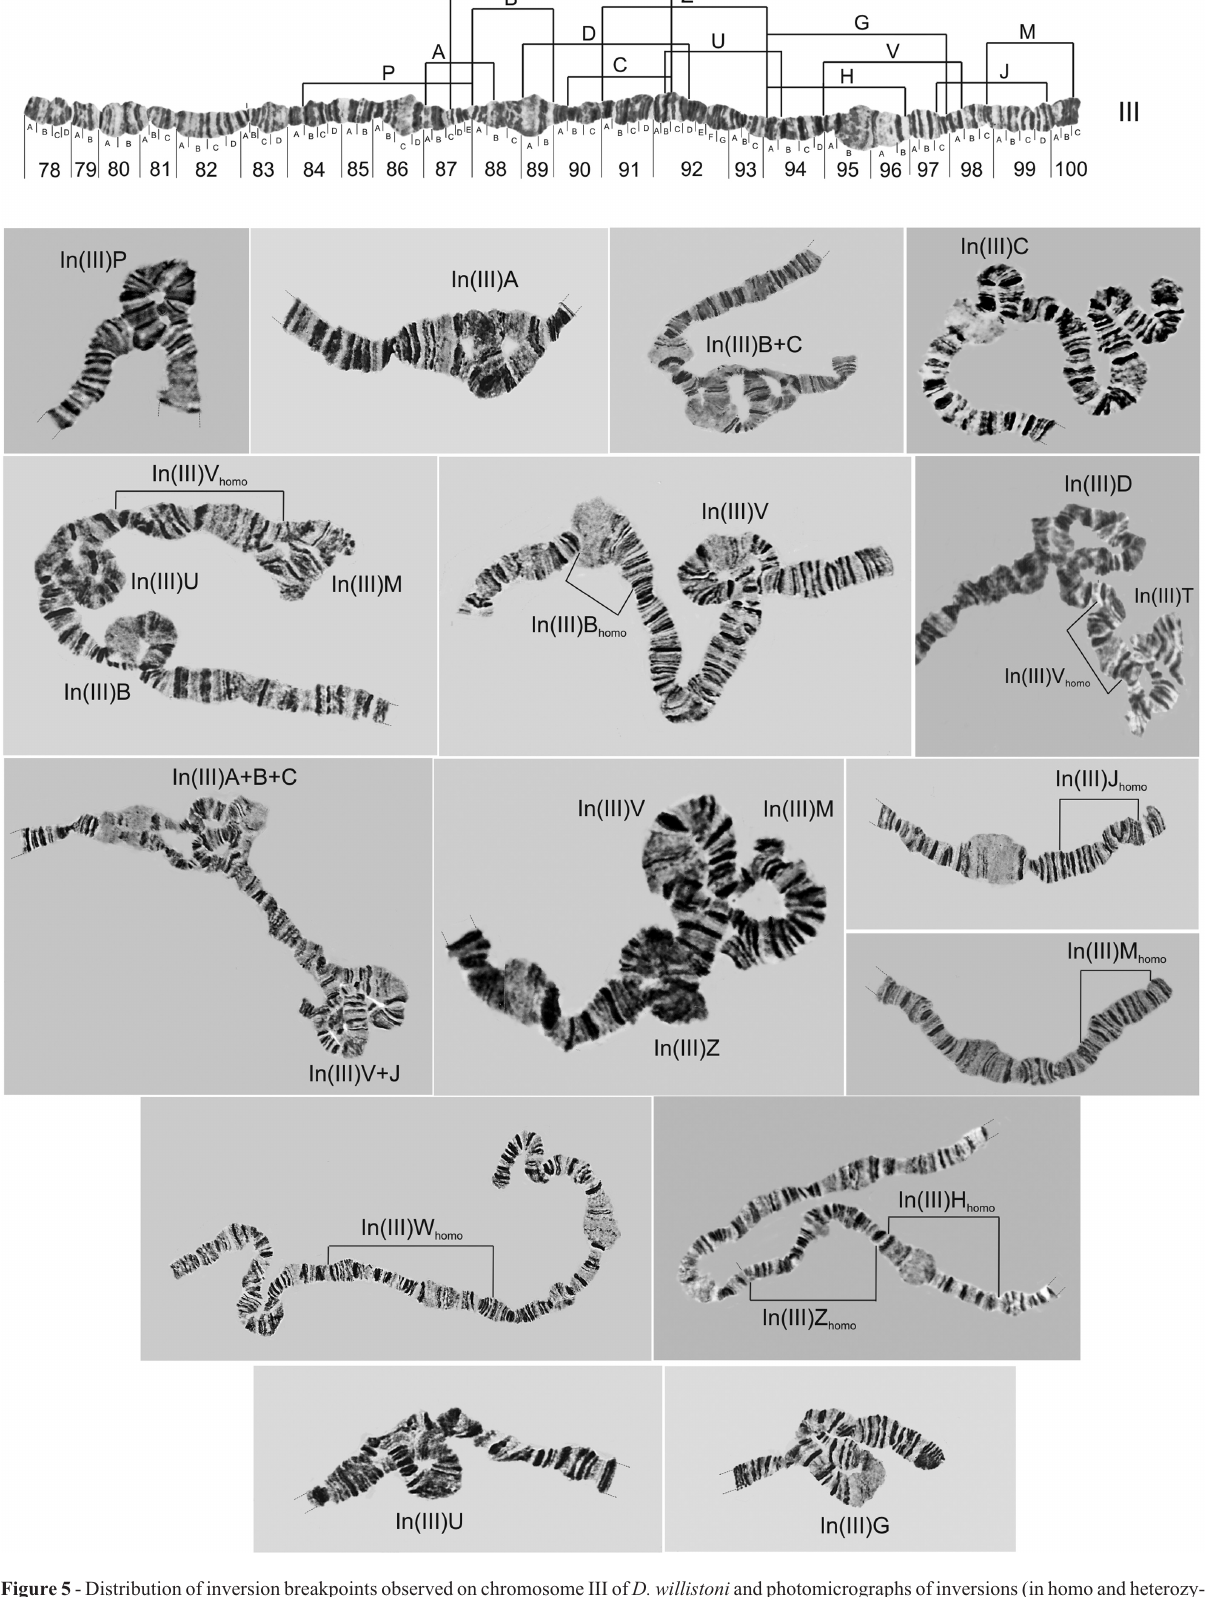
Figure5 -DistributionofinversionbreakpointsobservedonchromosomeIIIof D.willistoni andphotomicrographsofinversions(inhomoandheterozy- gous state)